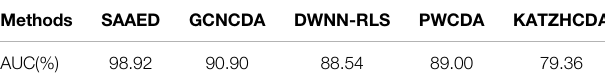
TABLE 3 | The fi vefold CV AUC scores generated by various models on the same benchmark dataset CircR2Disease.